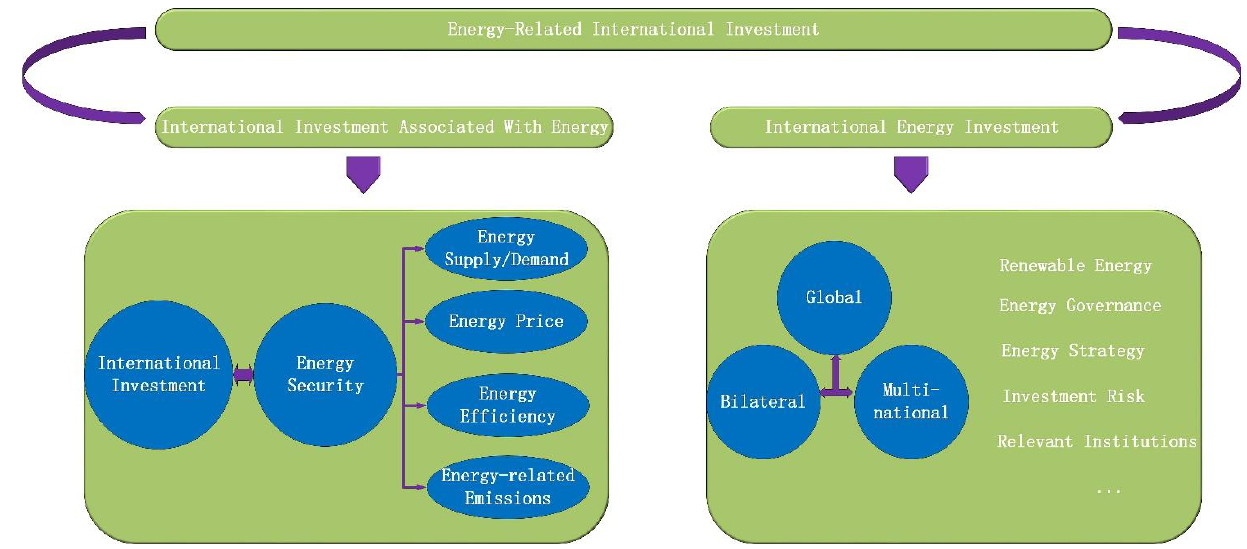
Figure 1. Distribution of existing research.